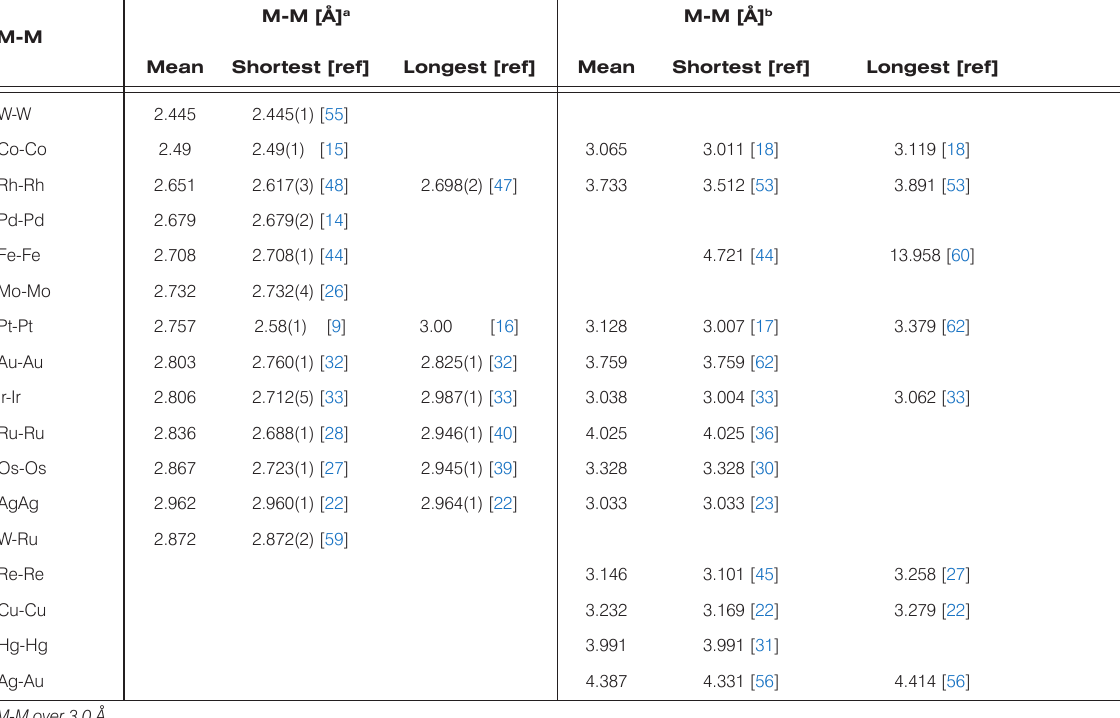
Table 4. Summary of the mean M-M distances in heteropentanuclear platinum